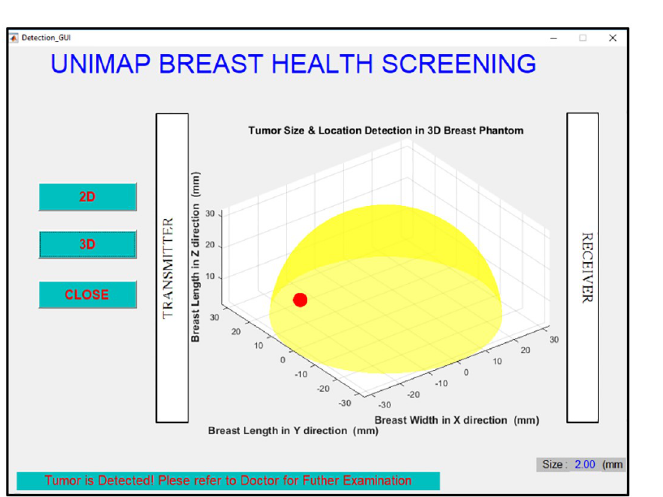
Fig 15. Visualization of detected 2 mm tumor size in 3D environment. Figure shows the example of visualization layout in the 3D environment to detect 2 mm tumor at the location of 2.5 mm, 32.5 mm and 50 mm for x, y and z coordinates.